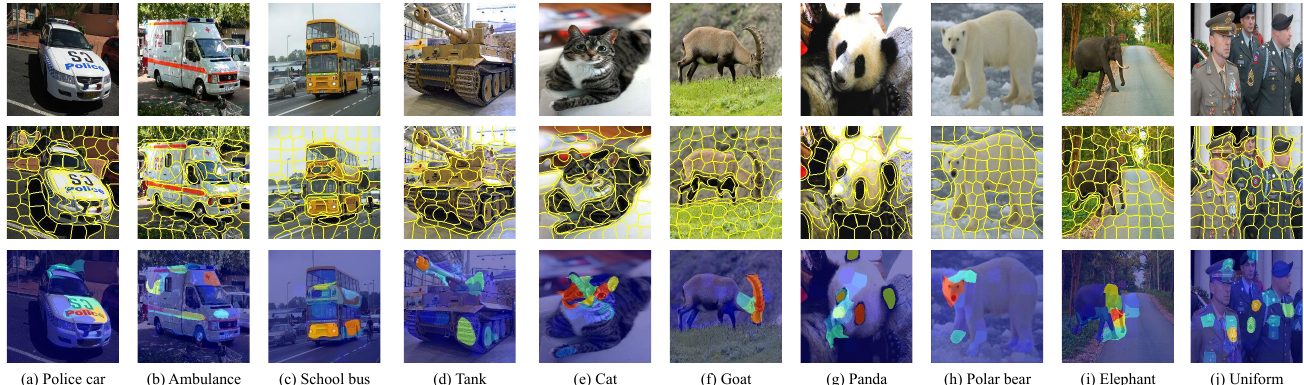
Figure A5. Examples of ground truth result of the relevant feature block marked by the user of each category. ( TOP ) Ten input image samples in ten categories from the evaluation data set DataS. ( Middle ) Segmented image with 100 feature blocks obtained according to the SLIC segmentation algorithm. ( Bottom ) Resulting multi-participants human attention mask. Each image is annotated by 40 unique